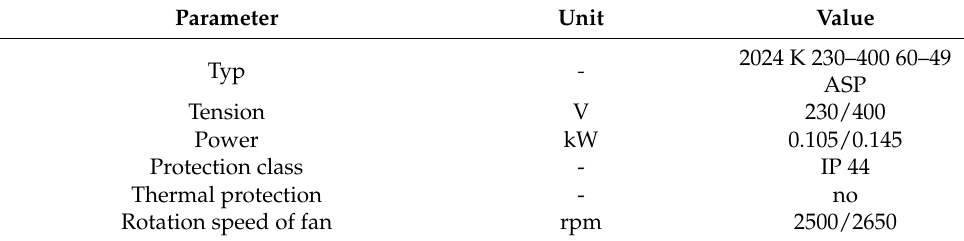
Table 9. Technical parameters of the cooler EMMEGI (C 1 , C 2